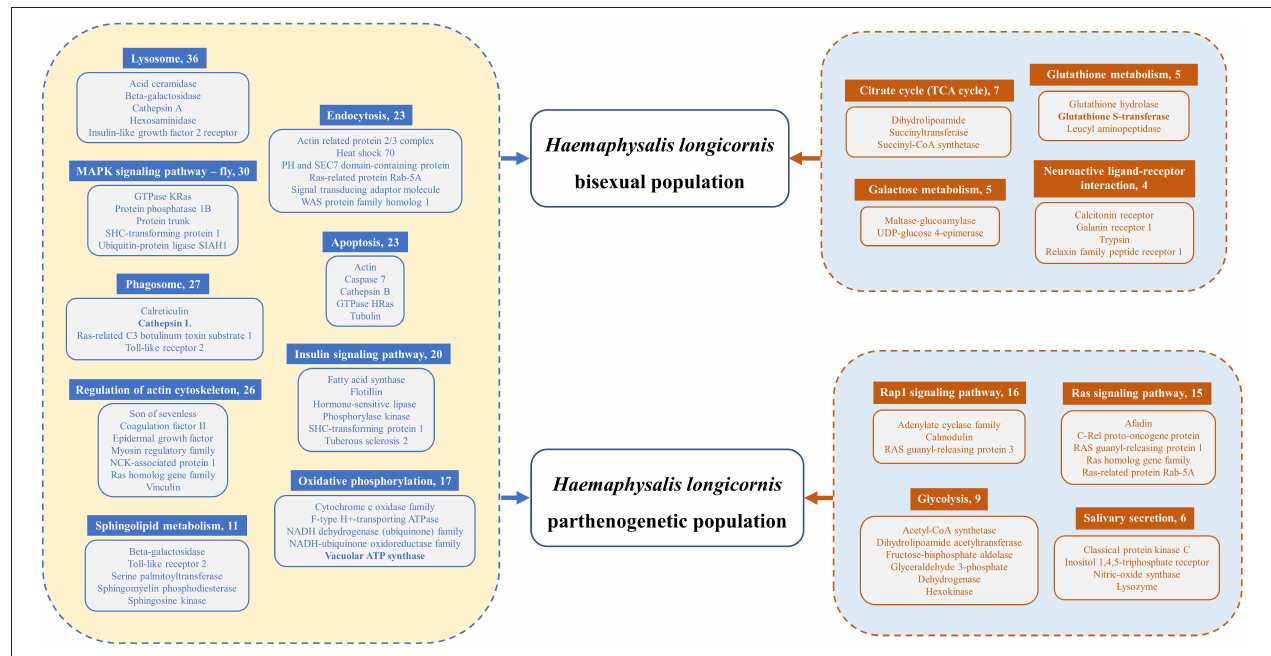
FIGURE 6 | Differentially expressed genes (DEGs) of functional pathways of HLBP and HLPP. The common upregulated genes of HLBP and HLPP are on the left side of the legend. The exclusive upregulated genes of HLBP or HLPP are on the right side of the legend. Numbers following the pathway names indicate the quantity of